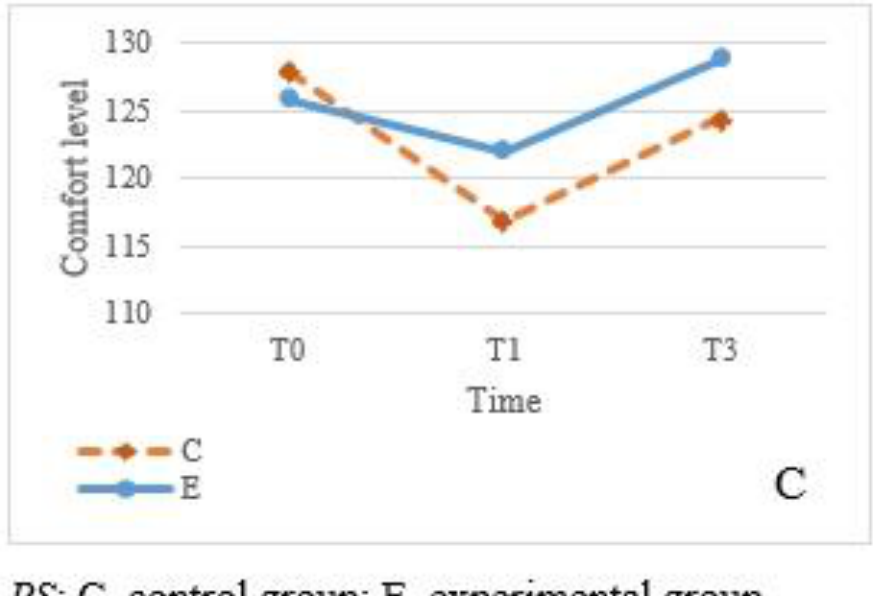
Figure 2. Changes in psychological indicators with time ( A ) VAS-A, ( B ) STA-Y1, and ( C ) comfort.